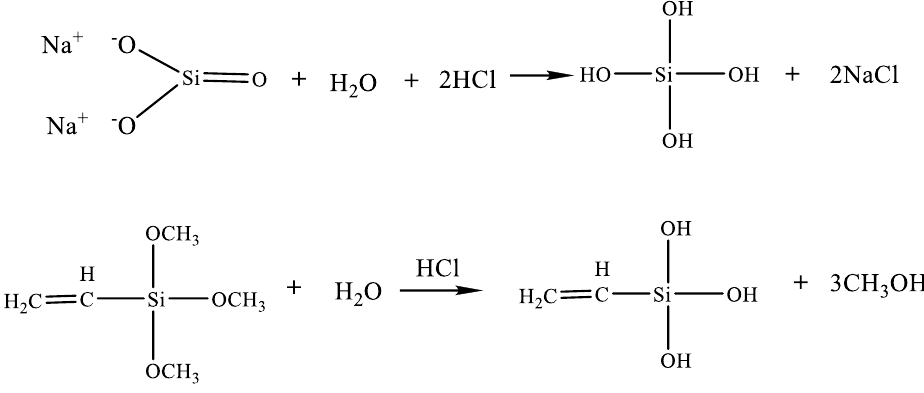
Figure 10. Mechanism of the hydrolysis reactions.